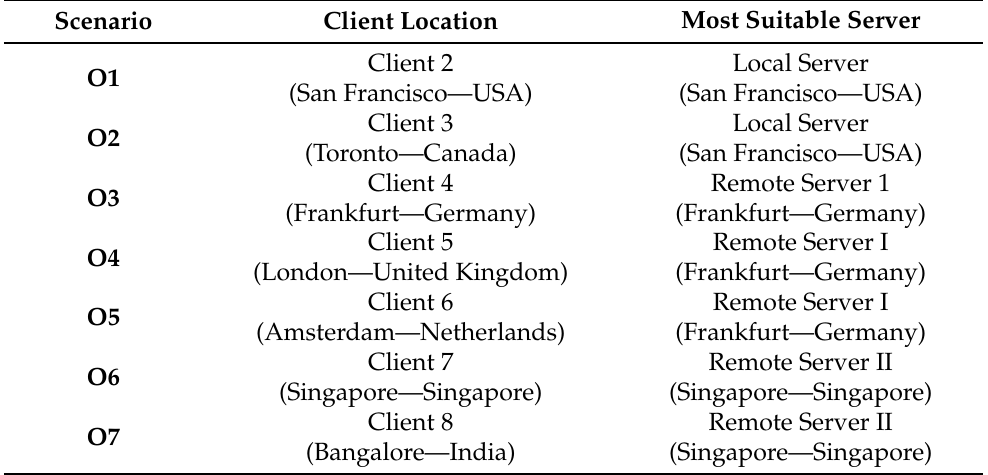
Table 14. Client location and most suitable servers for Type 4 (Synchronization) and Type 6 (Localiza- tion by IP address) queries.